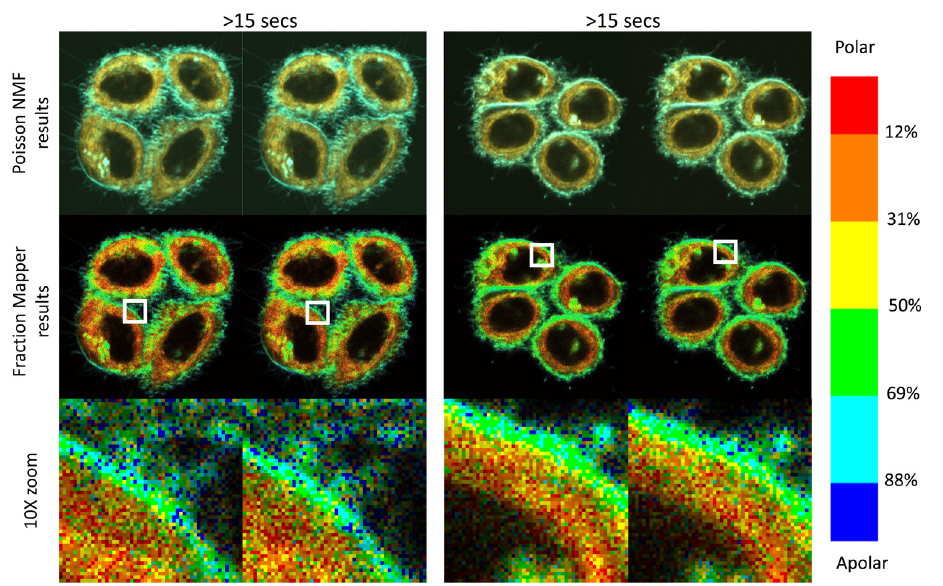
Figure 12. Using 2 sequential acquisitions 15 seconds apart to ensure that the acquisition has not modified the membranes or damaged the cells. Hela cells grown for two days on glass coverslips were stained with 200 nM C-laurdan and imaged twice sequentially with the standard conditions defined in M&M (power 4%, speed 6, 4 averages, pinhole 150). With these setting, the acquisition procedure takes 15 seconds. The second picture is thus taken 15 seconds after the first one. Z4:Whole image : 53 µm, 1 pixel = 100 nm HELA C Laurdan 200 nM, Laser at 720 nm, Z4, power: 4%, speed: 6 (6 usec/pixel), average on 4 measures, pinhole: 150 Hela CL 4 and Hela CL 5 15 Oct